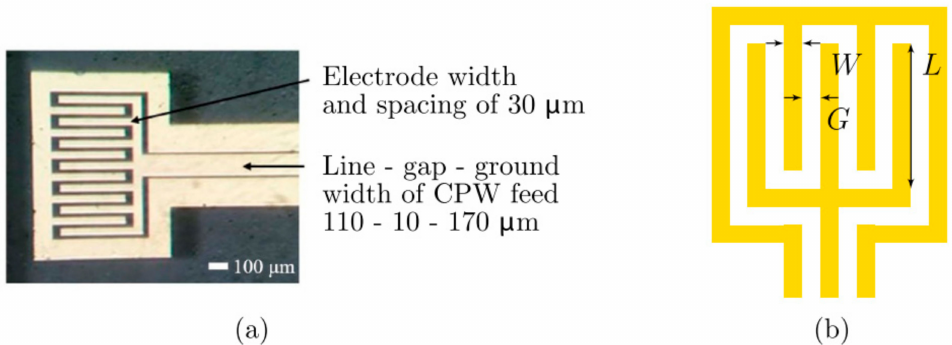
Figure 14. The manufactured interdigital capacitor (IDC)-based sensor ( a ) and the schematic overview, which shows the circuit’s dimensions ( b ) [99]. Reprinted from Maenhout, G.; Markovic, T.; Bao, J.; Stefanidis, G.; Ocket, I.; Nauwelaers, B. Dielectric-based temperature sensing of nanoliter water samples with a post-processing tuned matching network. Meas. Sci. Technol. 2020 , 31 , doi:10.1088/1361-6501/ab9937 with permission from IOP Publishing